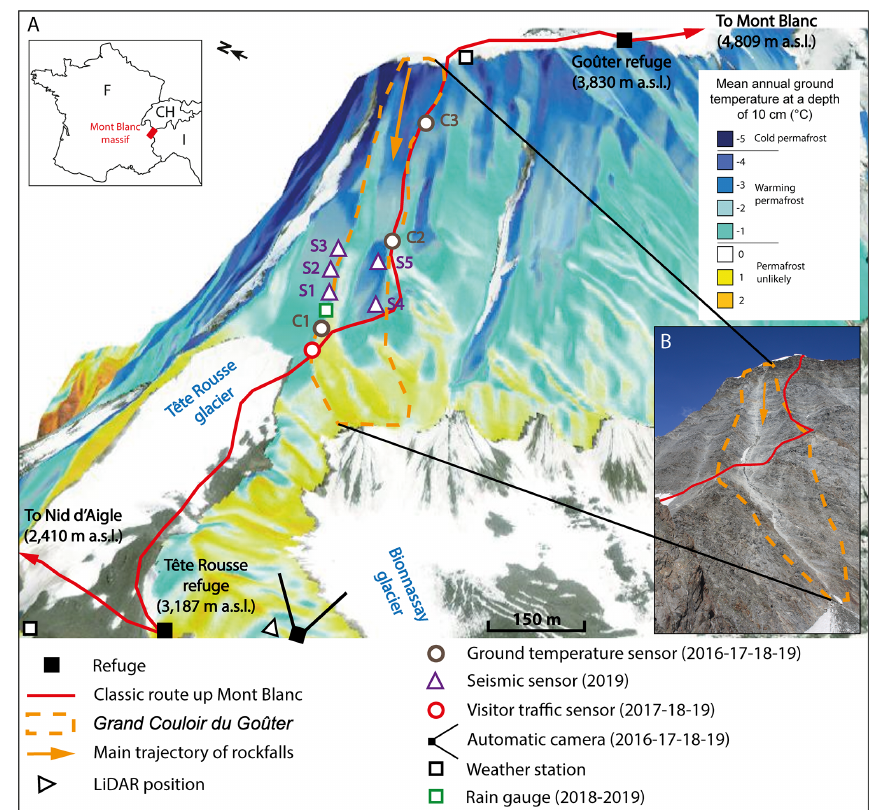
Figure 1. Study site and multi-method monitoring system at the Grand Couloir du Goûter. (a) Permafrost map from the modelling of Magnin et al. (2015) (aerial photography © Microsoft) showing the locations of the classic route up Mont Blanc on the west face of the Aiguille du Goûter (in red) and the instruments set up in the area. The years in which the sensors were present are indicated. (b) Picture of the couloir taken by the automatic camera (4 August